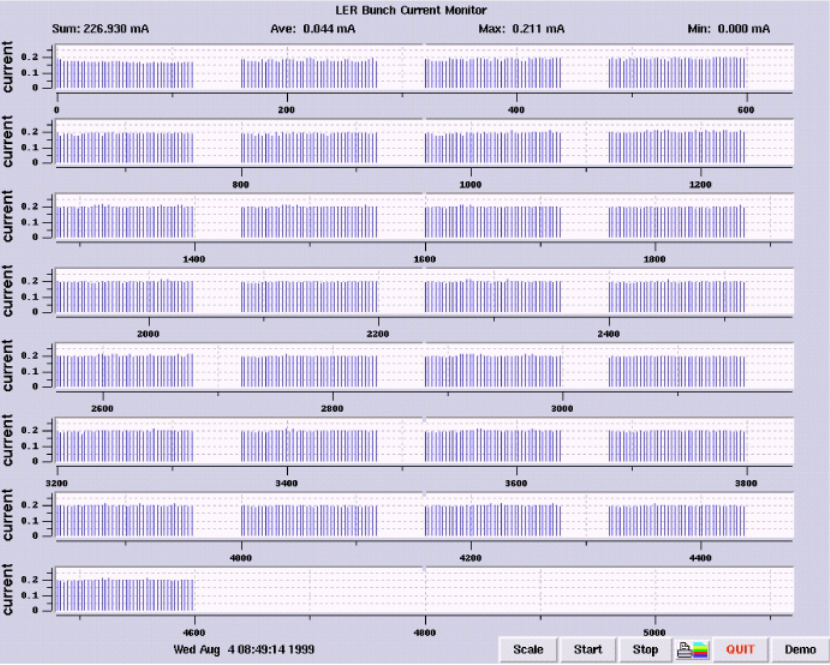
FIG. 9. (Color) Example of the filling pattern during a physics run. The bunch spacing was 6 ns.